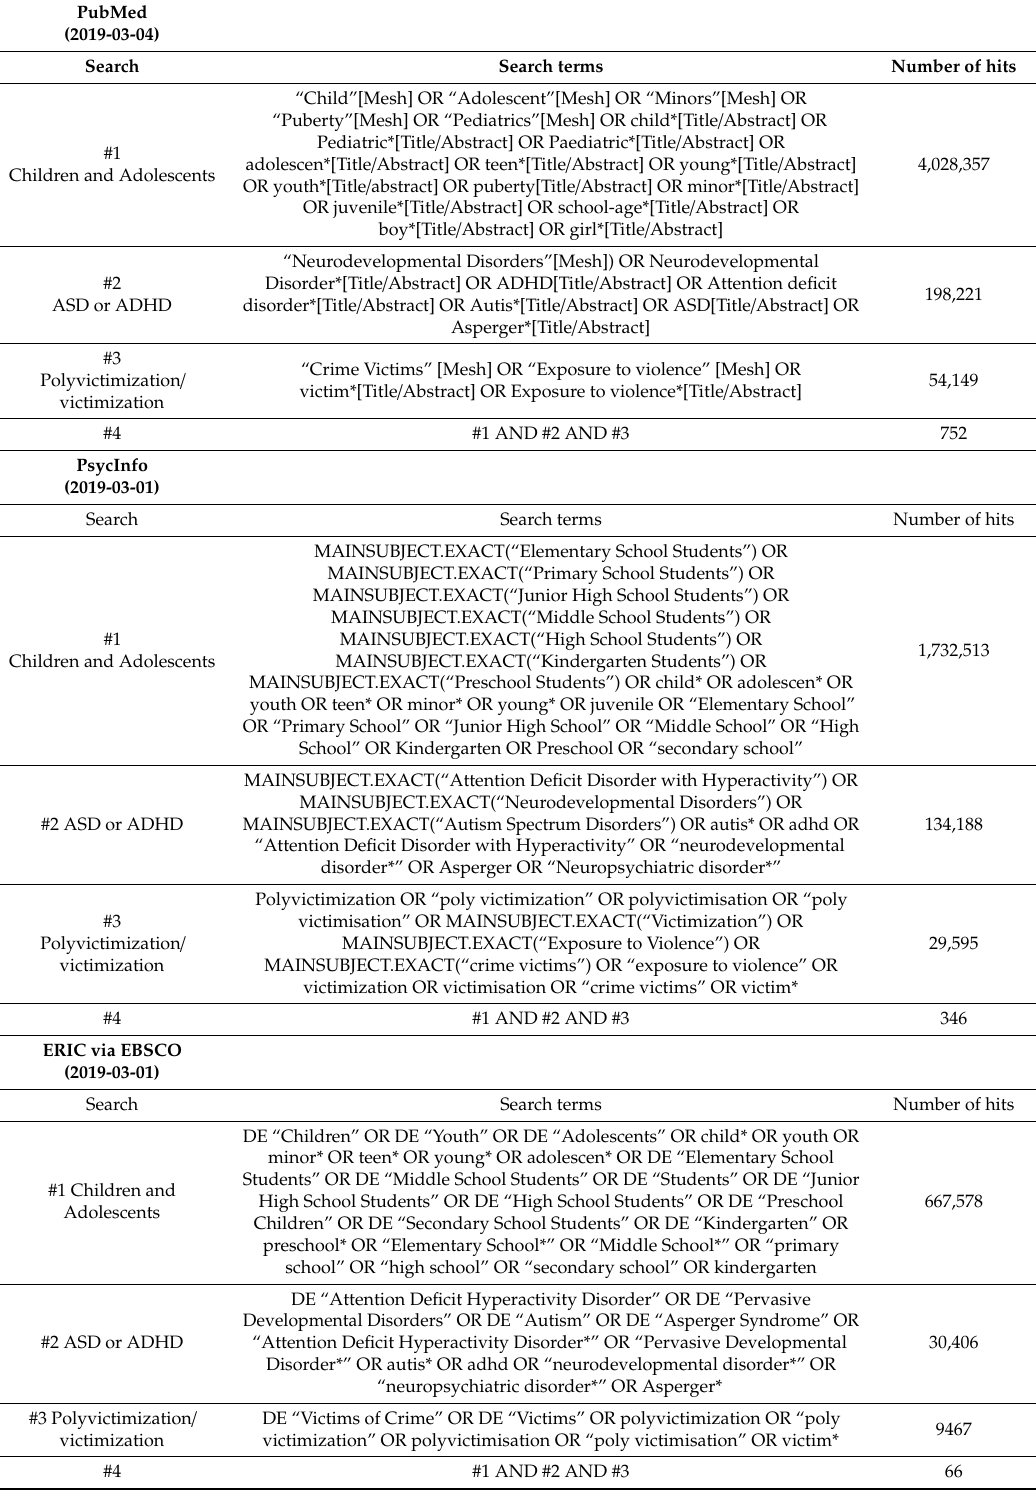
Table A1. Search terms and number of hits in each